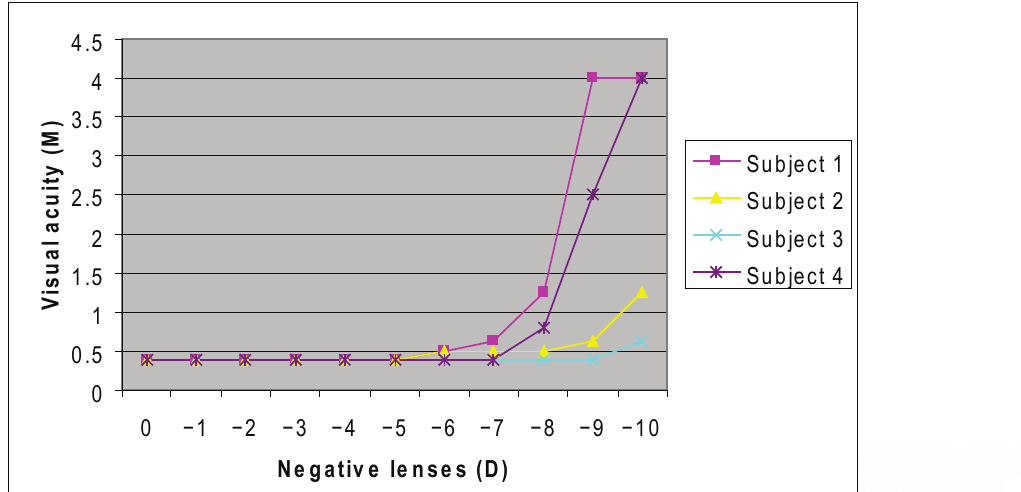
Figure 9. Effect of negative lenses on visual acuity while viewing a near acuity chart at 0.4 m through a pinhole with a 2 mm diameter and illumination of 460